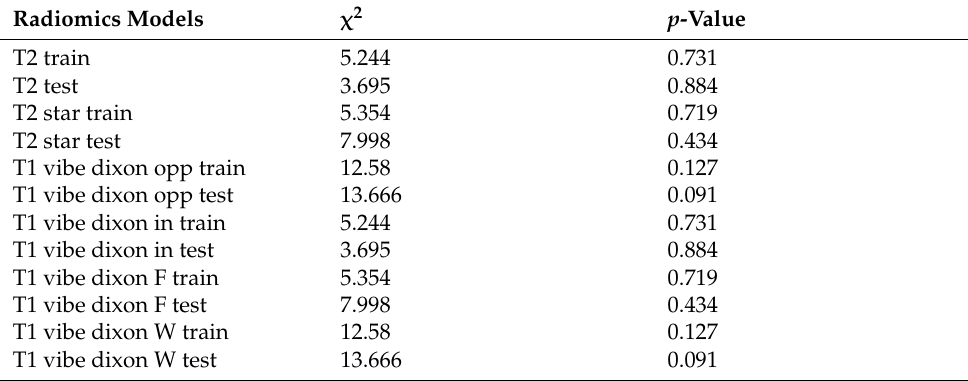
Table A1. Results of the Hosmer–Lemeshow tests for different radiomics